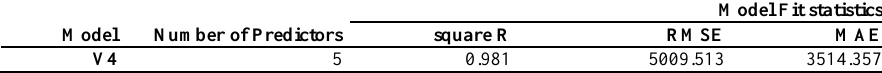
Table 11. The obtained error value in ARIMA model using the factors of this work.